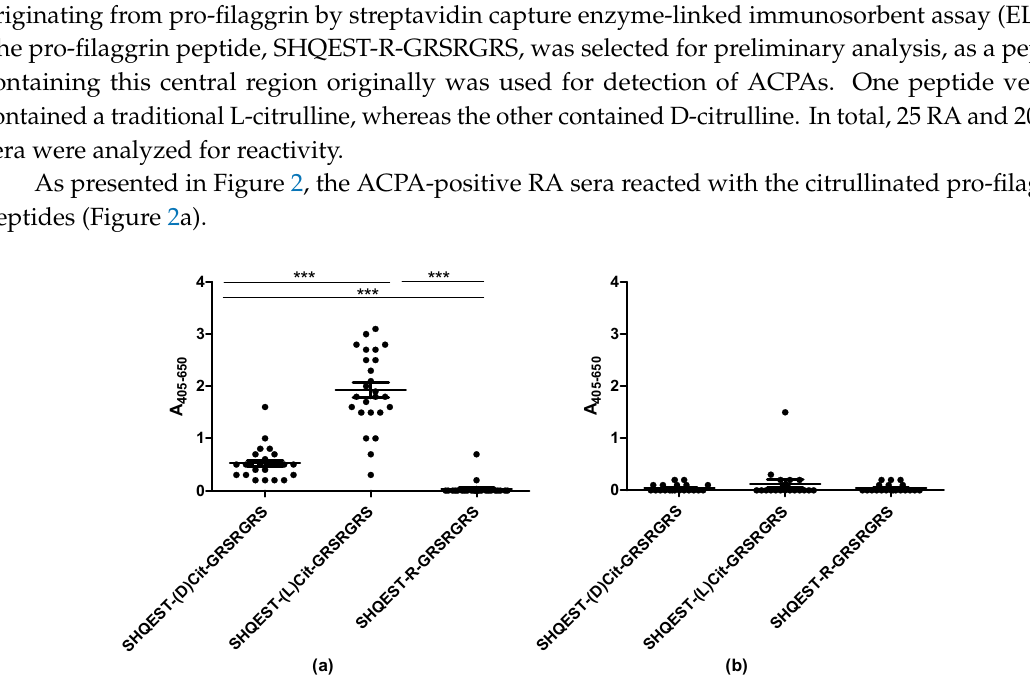
Figure 2. Antibody reactivity to a citrullinated pro-filaggrin peptide containing D- or L-citrulline analyzed by streptavidin capture ELISA. The Arg-containing pro-filaggrin, with a natural L-Arg was used as negative control. ( a ) Reactivity of RA sera ( n = 25); ( b ) Reactivity of healthy control (HC) sera ( n = 20).